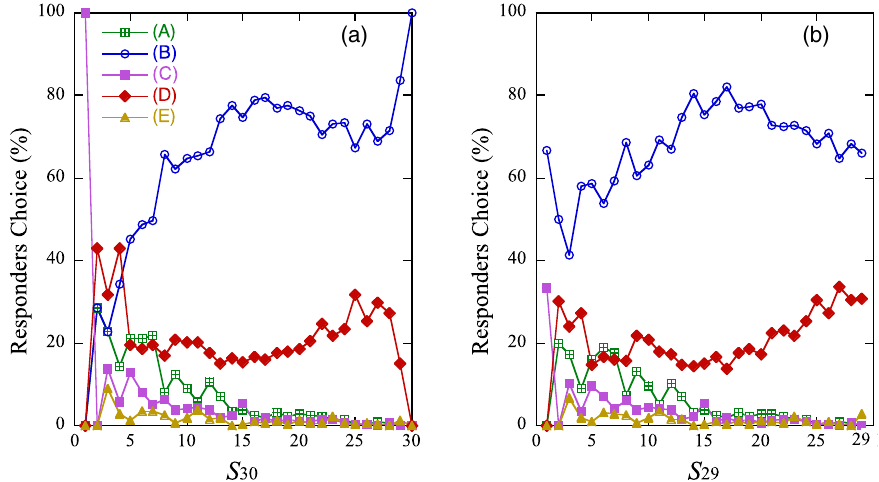
FIG. 3. Item response curve of Q.29. (a) Normal IRC using the score of 30 Items. (b) Modified IRC using the score of 29 items other than that of Q.29 as a proxy of the students ’